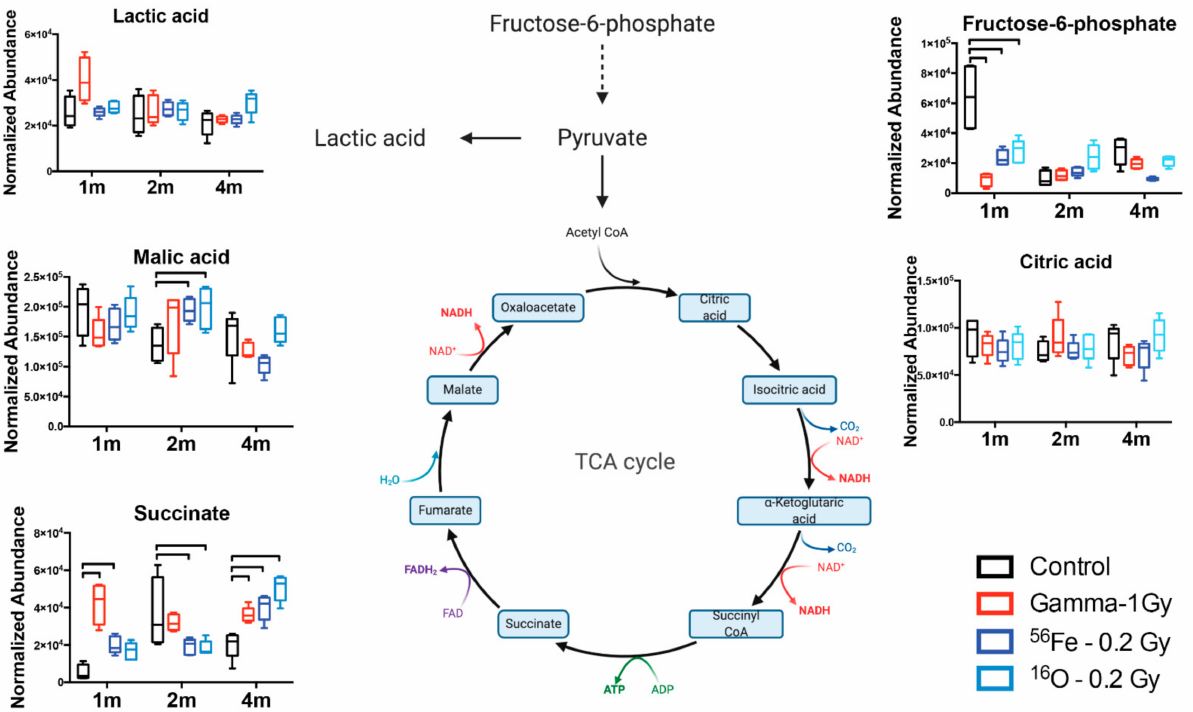
Figure 5. Changes in the TCA cycle highlight the dysregulation that increases with time and radiation quality. Brackets correspond to a p < 0.05 of an exposed group compared to control within that time point. TCA cycle figure was created with BioRender.com (accessed on 25 January